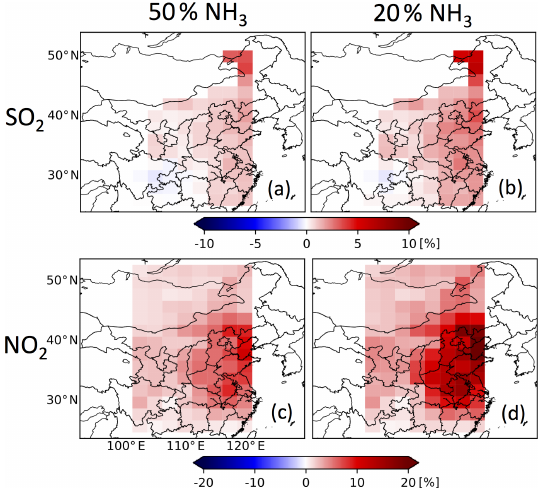
Figure 11. Sulfate–nitrate–ammonium aerosol optical depth in prior (a) and posterior joint inversion ( γ = 500) (b) . Panel (c) shows the difference between (b) and (a) , and (d) shows the rel- ative change in